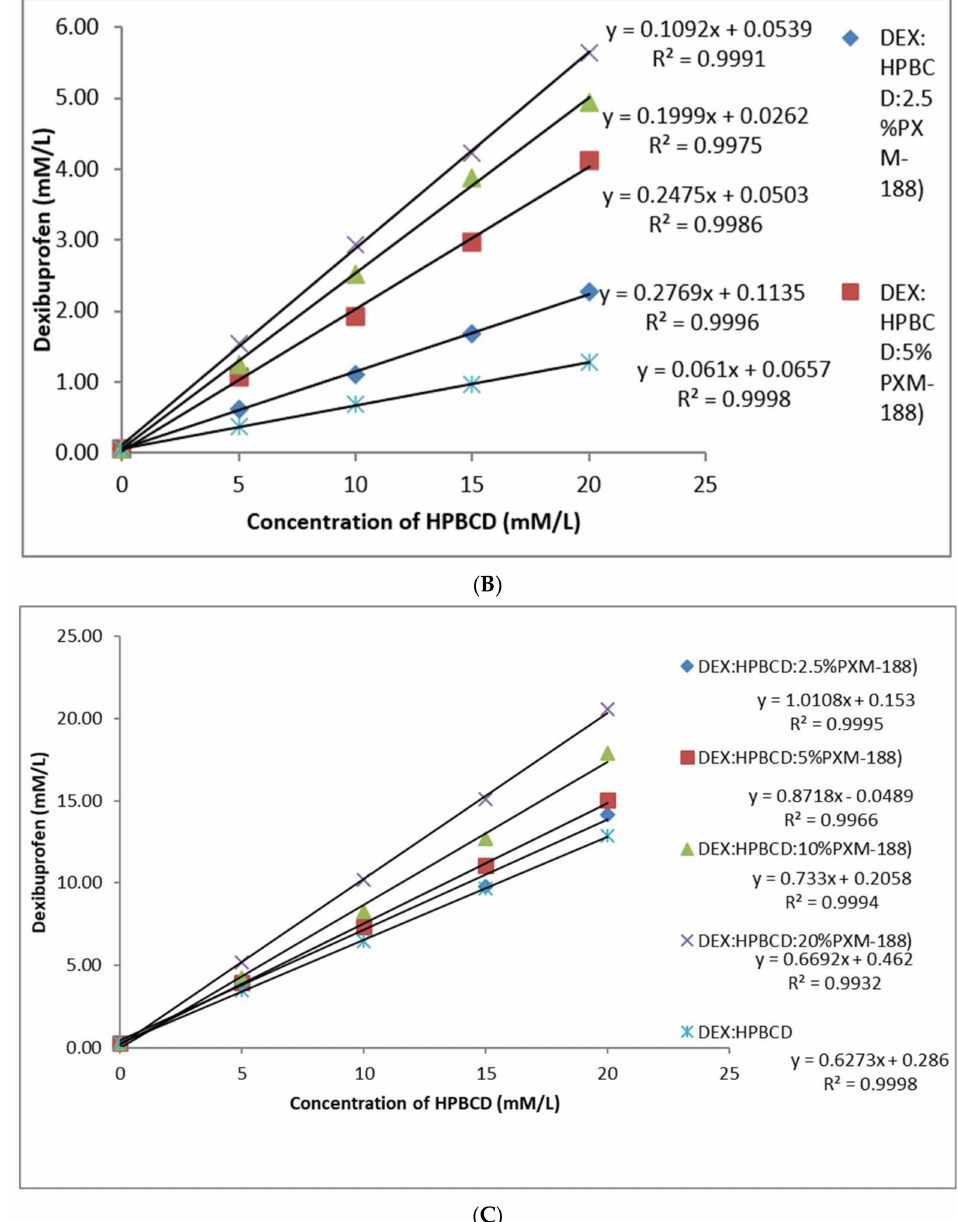
Figure 2. ( A ) Phase solubility diagram of DEX in aqueous solution of HP β CD mean ± SD, n = 3. ( B ) Phase solubility diagram of DEX in aqueous solution of HP β CD with/without PXM − 188. ( C ) Phase solubility diagram of DEX in aqueous solution of HP β CD with/without PXM −